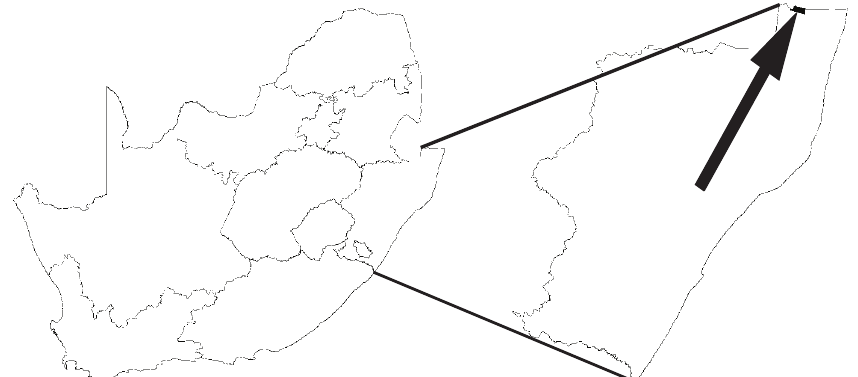
Fig. 1. Location of the Ndumo Game Reserve in northern KwaZulu-Natal, South Africa, as indicated by the